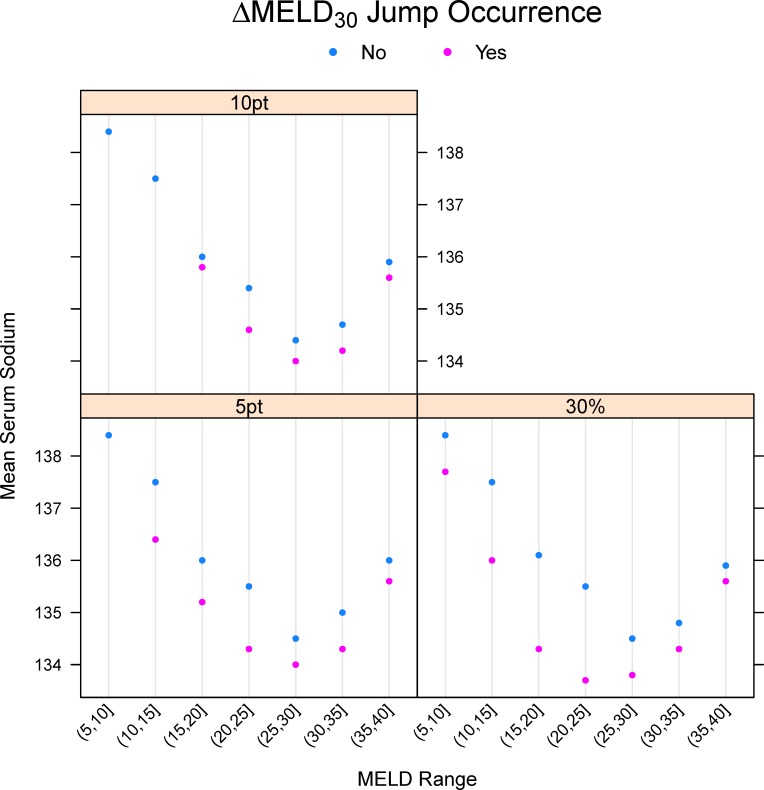
Mean serum sodium for patients with and without occurrence of a ΔMELD30 jump.